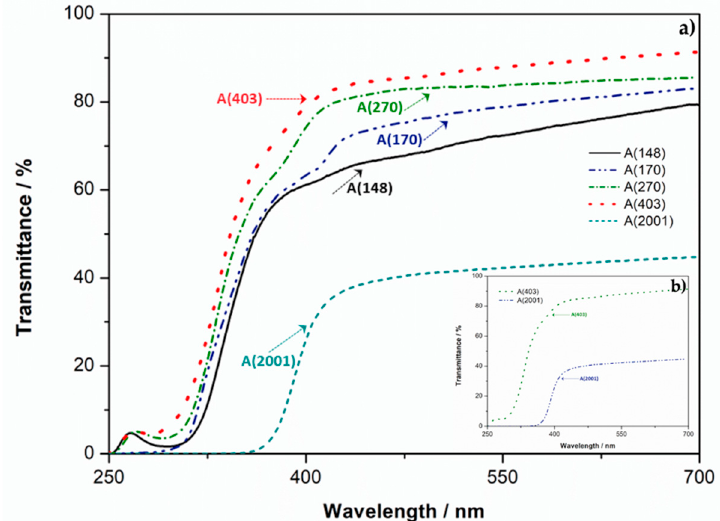
Figure 2. UV-visible transmission spectra obtained for xerogel films ( a ) A(148), A(270), A(403), A(170), and A(2001) and as an inset detail of ( b ) A(403) and A(2001).